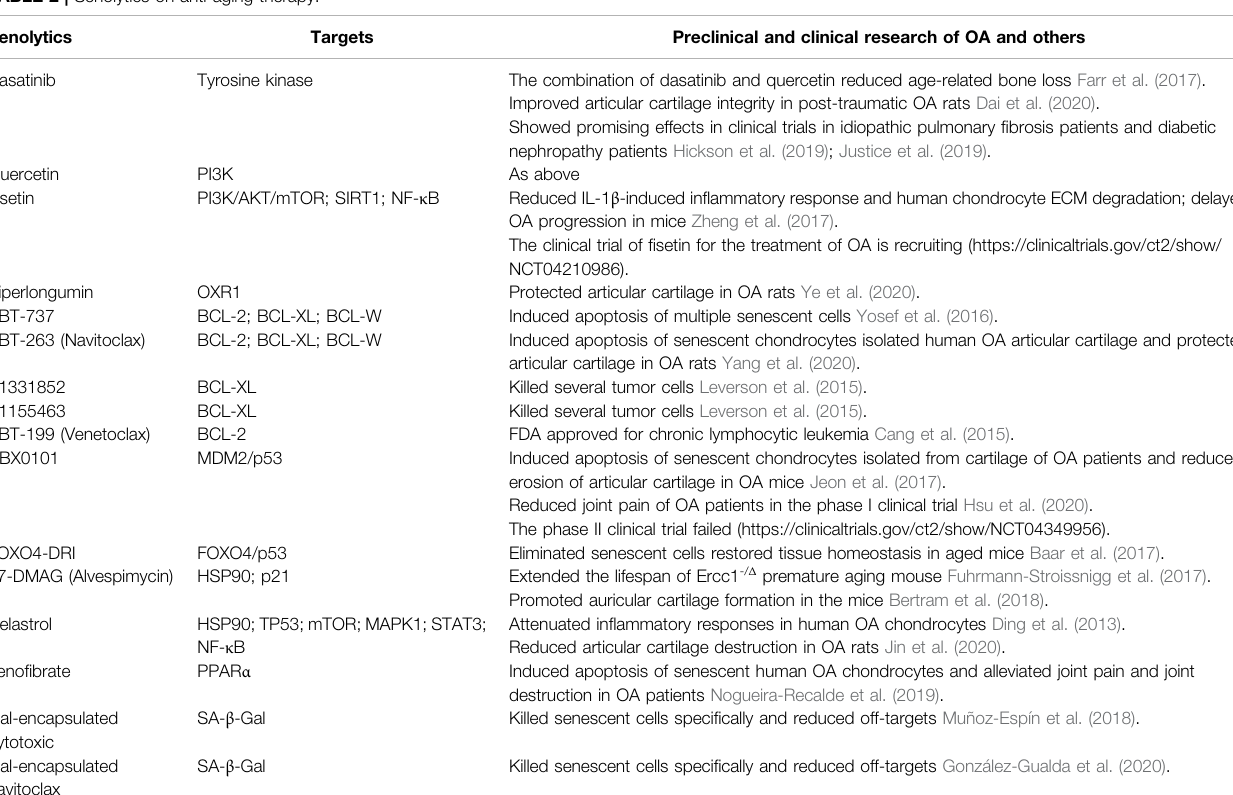
TABLE 2 | Senolytics on anti-aging